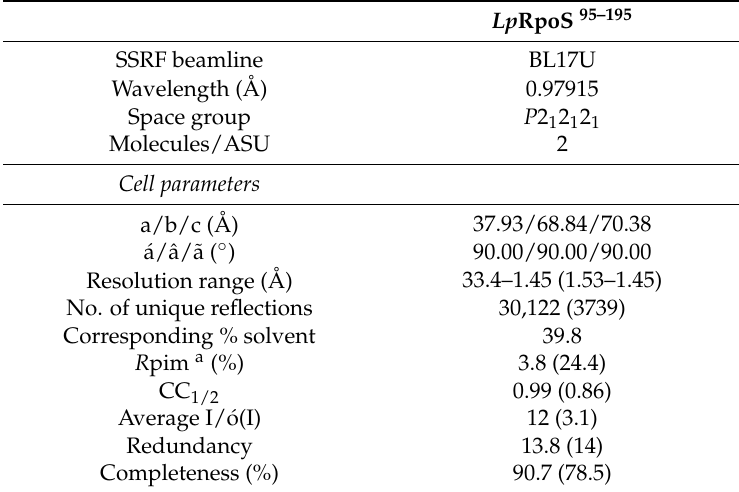
Table 1. Data collection and refinement